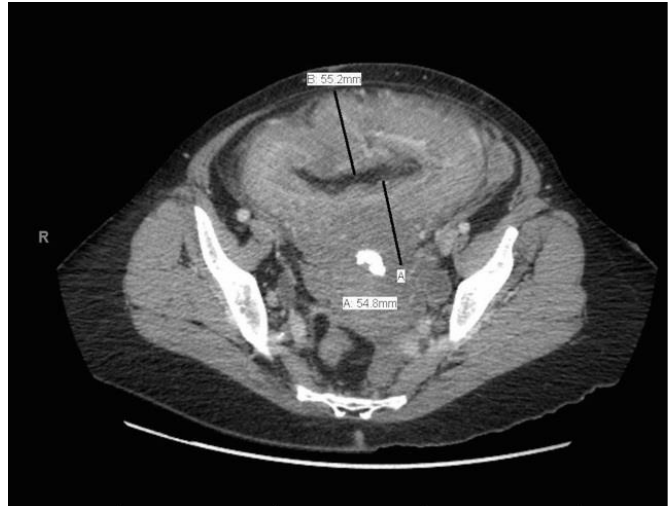
Figure 1. Computed tomography of enlarged, nondistended urinary bladder with diffusely thickened wall shown in transverse view after placement of a urinary